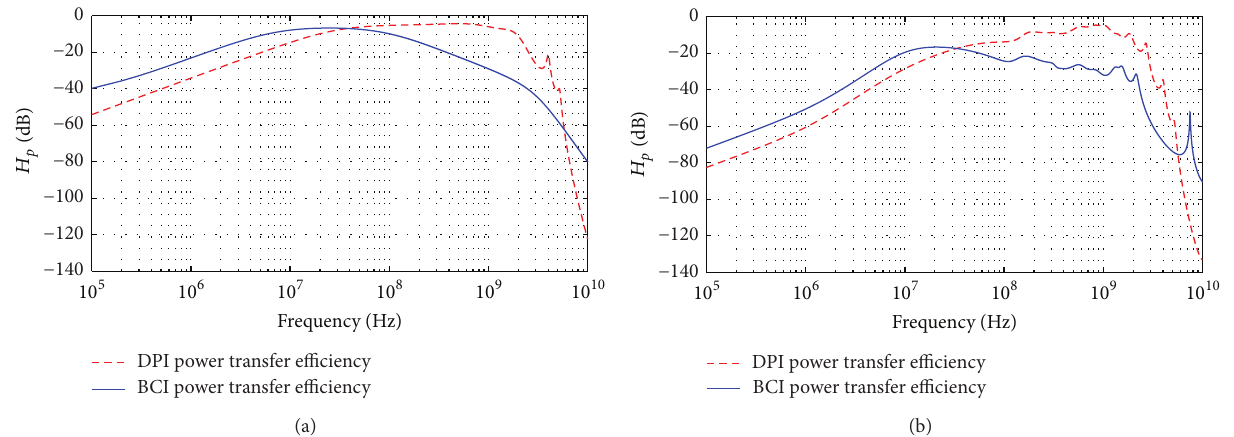
Figure 18: Comparison of DPI and BCI power transfer efficiency. (a) With 50 Ω load. (b) With chip VDD/VSS port impedance load.